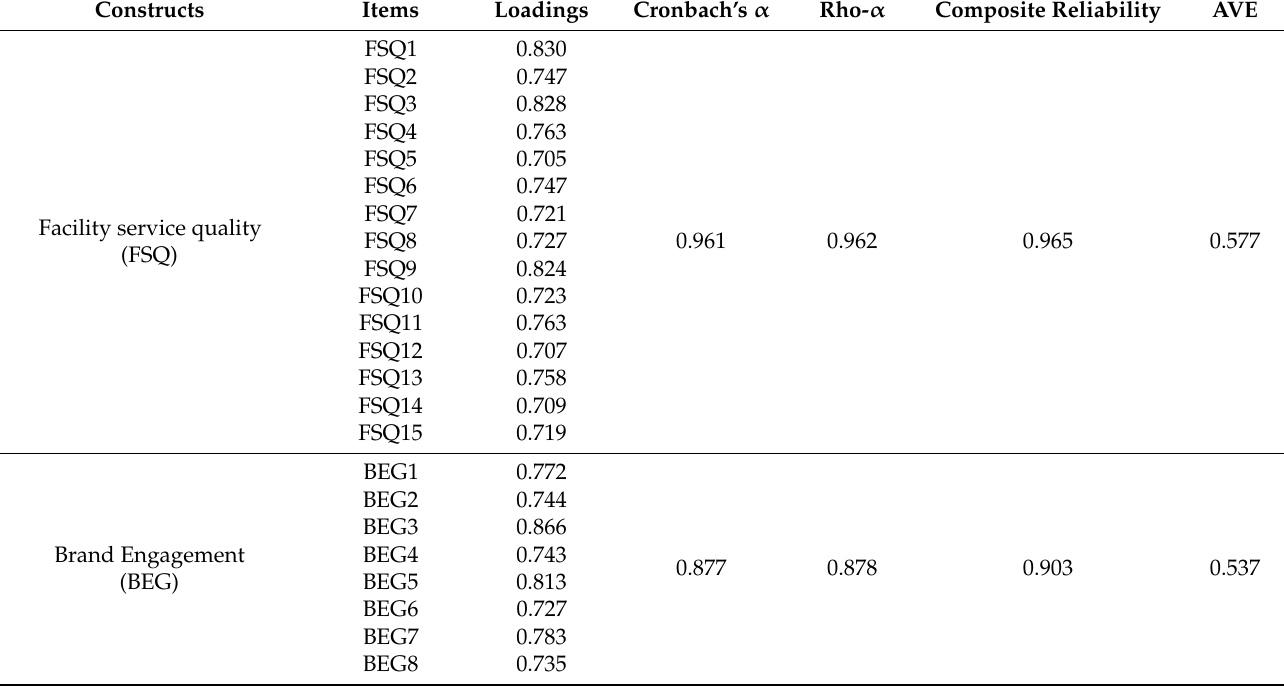
Table 2. Confirmatory factor analysis